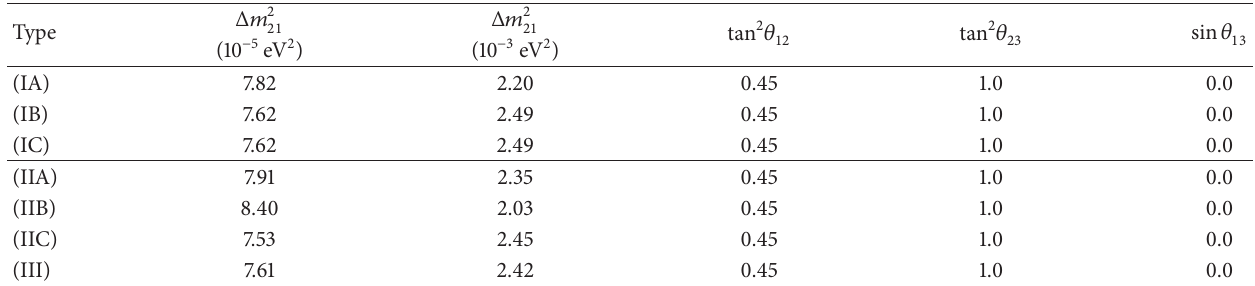
Table 1: Predicted values of the solar and atmospheric neutrino mass-squared differences and mixing angles for tan 2 𝜃 12 = 0.45 .